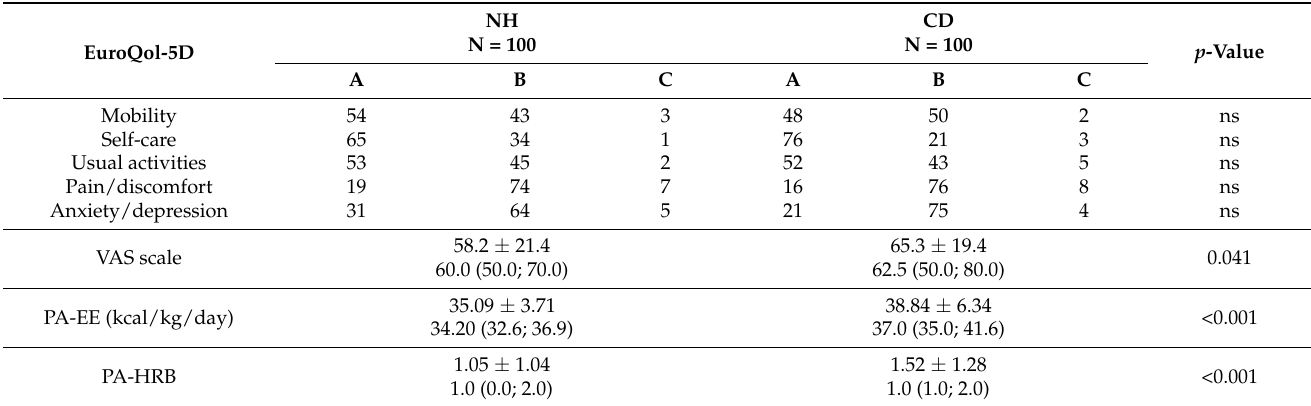
Table 2. A comparison of QoL-5D, VAS scale and PA in the NH and CD groups.